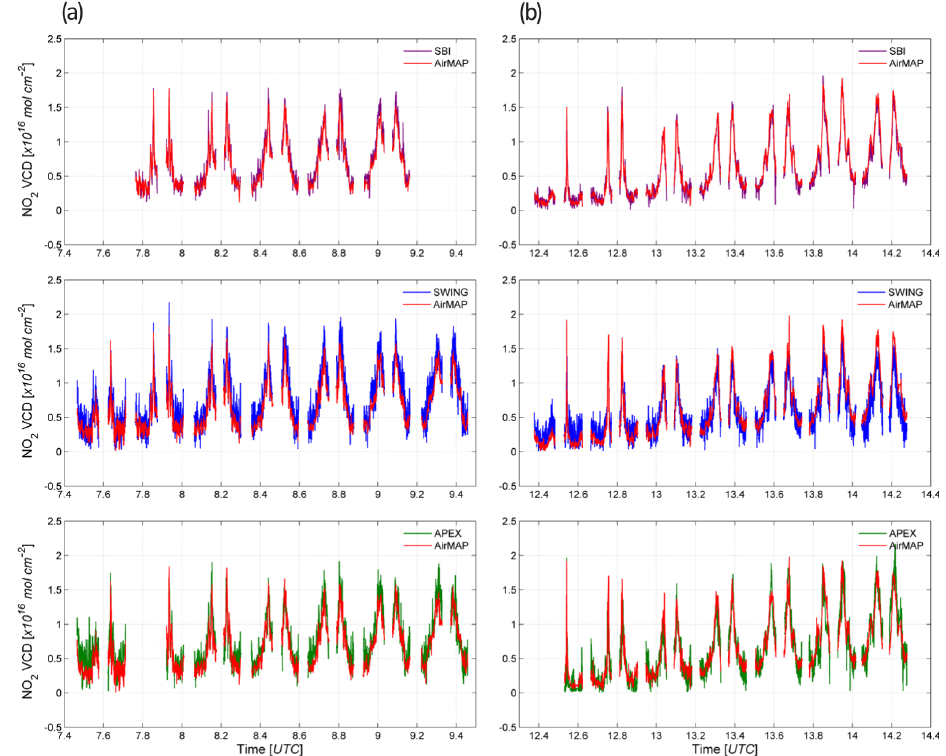
Figure 18. Co-located NO 2 VCDs retrieved from the harmonised maps for respectively (a) the morning and (b) afternoon flights on 21 April 2016. APEX VCDs are provided in green, AirMAP in red, SWING in blue, and SBI in purple. The x axis corresponds to the acquisition time, recorded by the Cessna 207T